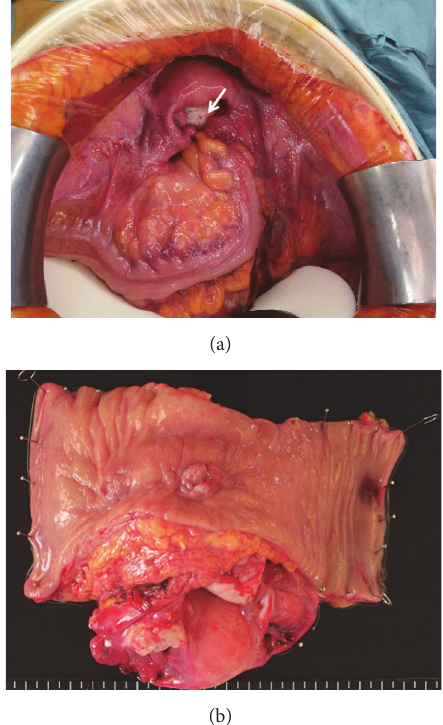
Figure 2: (a) At laparotomy, a left ovarian mass (arrow) was found adheringtotherectosigmoidcolon.(b)Resectedspecimenrevealing perforation into the rectum.